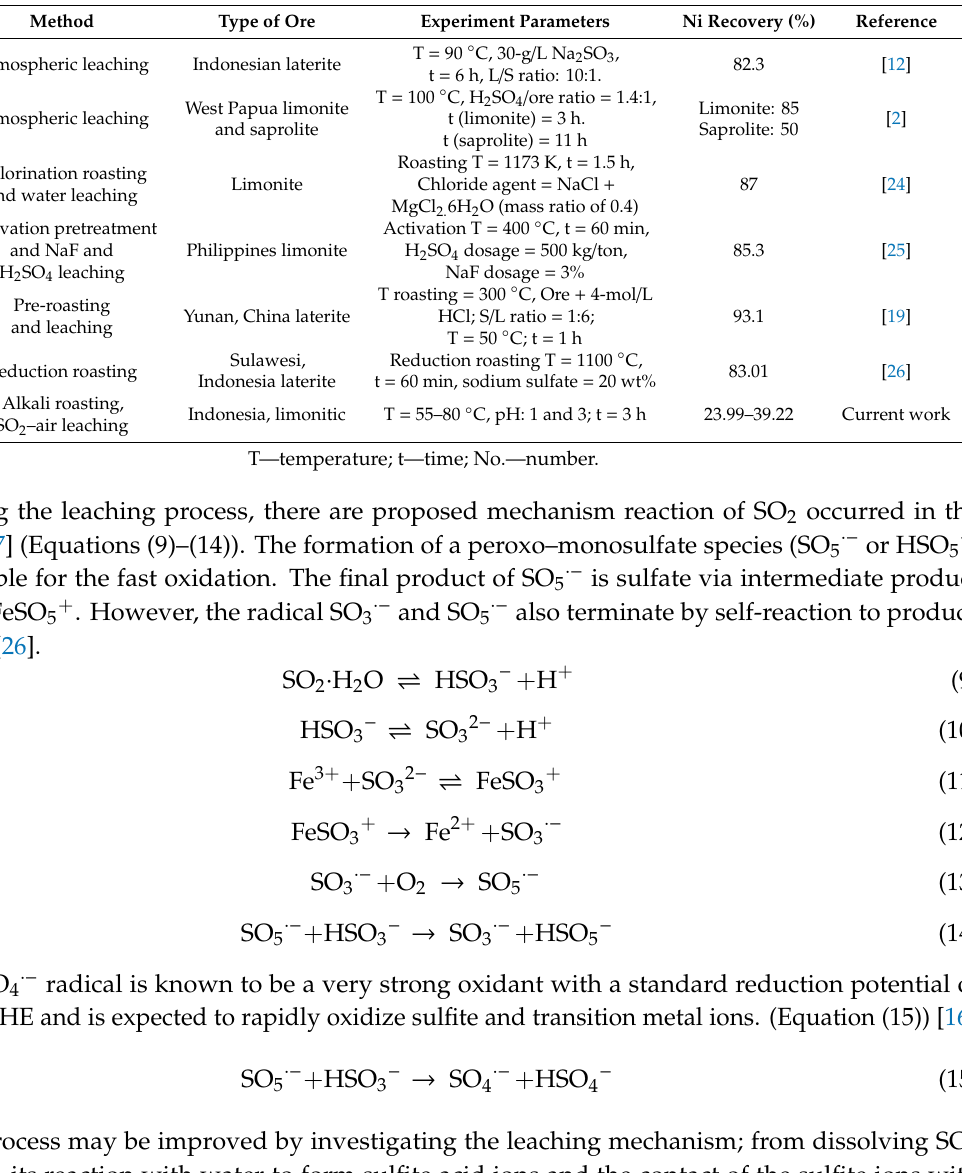
Table 3. Summary of leaching process of limonite ores